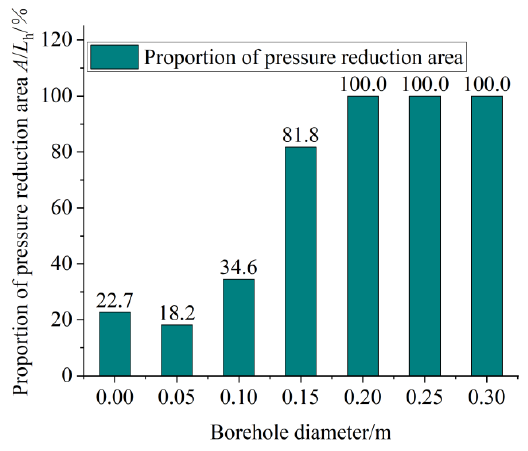
Figure 5. Proportion of the pressure relief area.